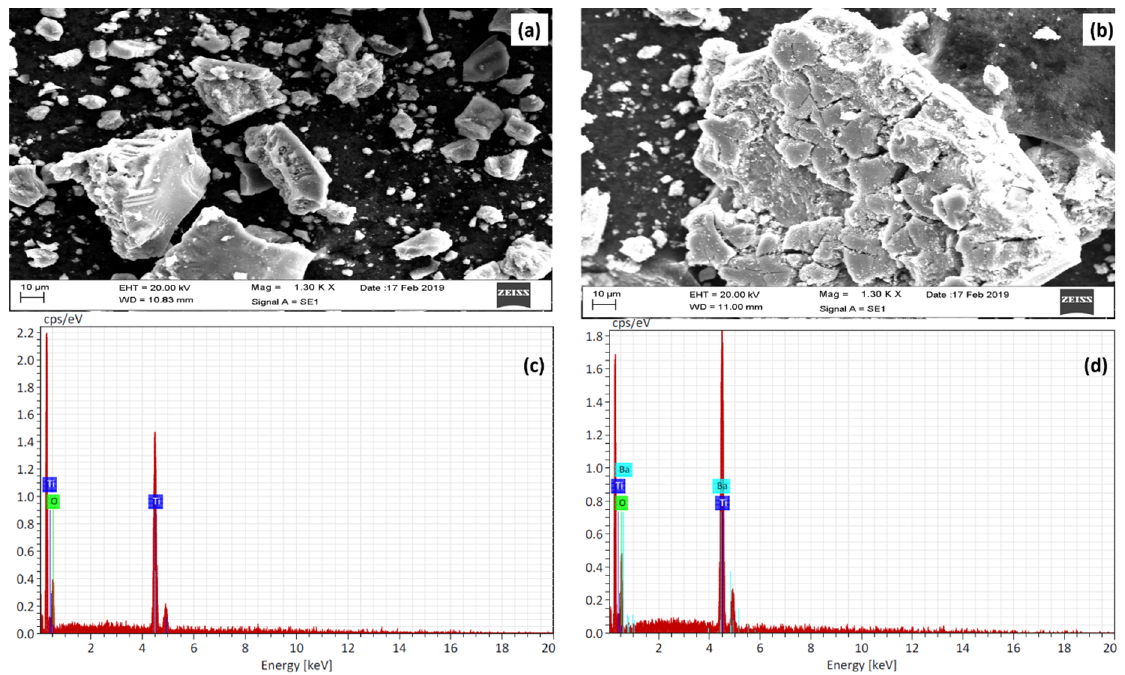
Figure 5. SEM analysis of synthesized ( a ) TiO 2 and ( b ) Ba/TiO 2 , and EDS analysis of synthesized ( c ) TiO 2 and ( d ) Ba/TiO 2